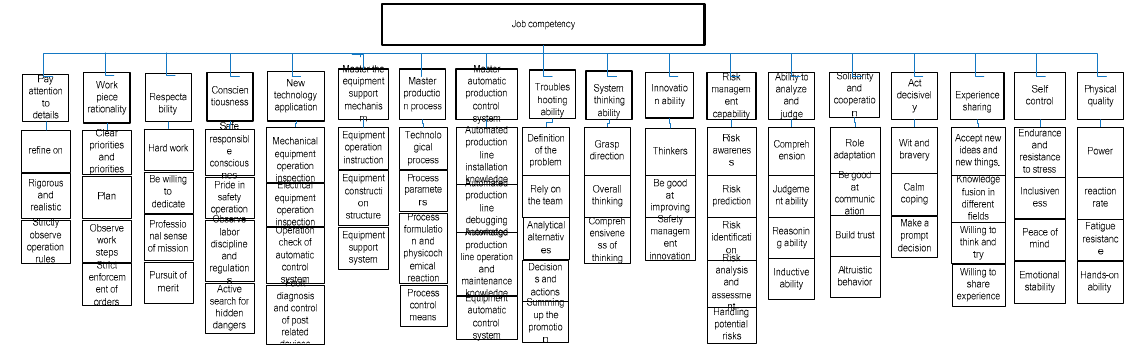
Figure 4. Competency index system for large metallurgical equipment workers.